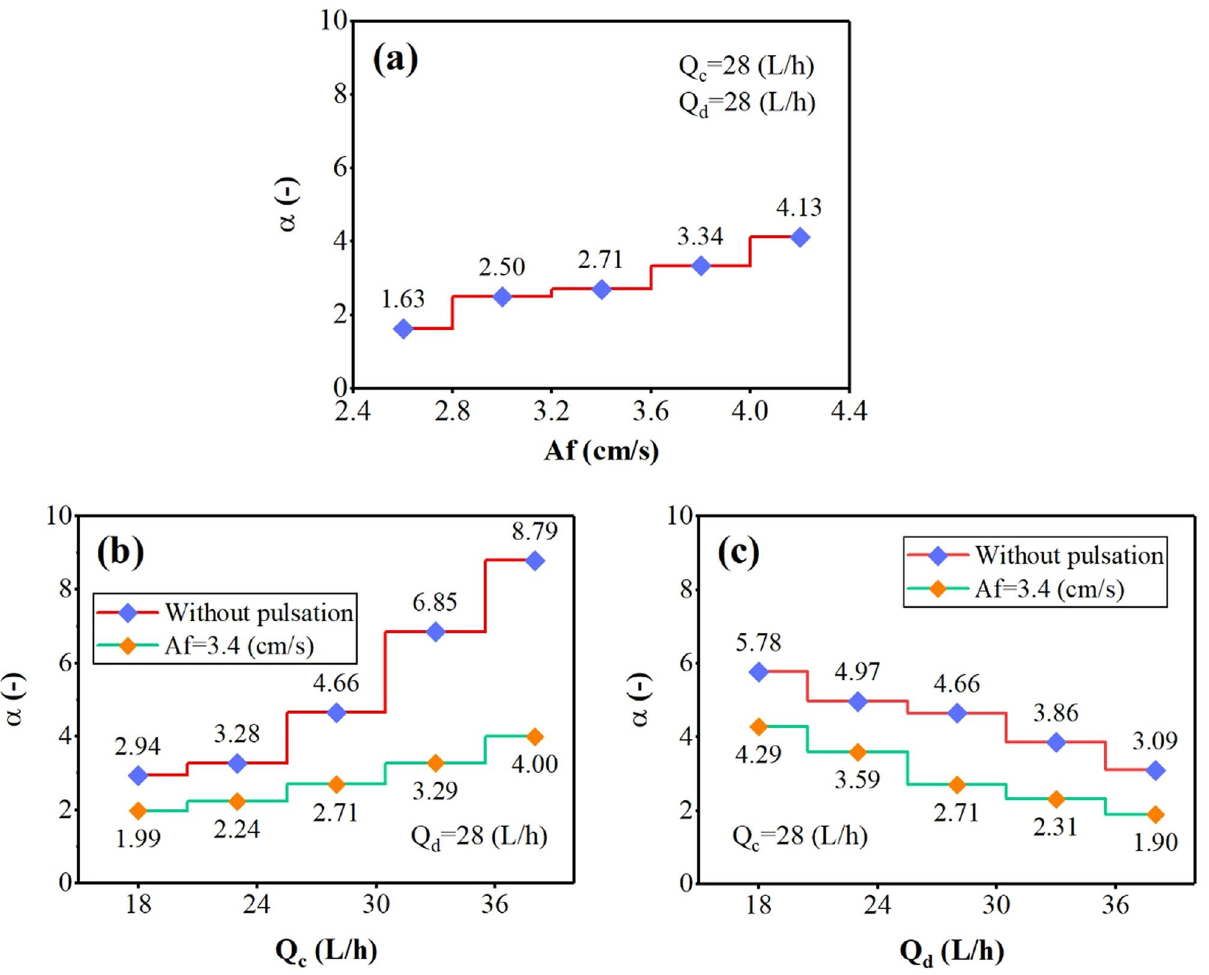
Figure 5. The effect of operating parameters [( a ) pulsation intensity, ( b ) aqueous phase flow rate, and ( c ) organic phase flow rate] on the continuous phase backflow